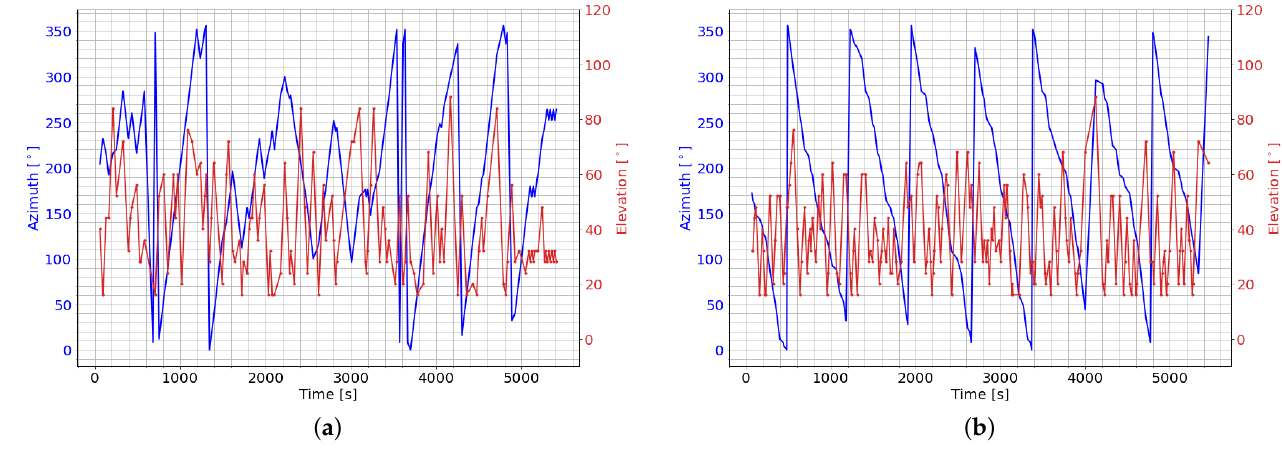
Figure 7. Pointing directions selected by DRL agent. ( a ) Azimuth and elevation pointing direction selected by the Dense-v1 3400 DRL agent; ( b ) Azimuth and elevation pointing direction selected by the CNN-v1 3400 DRL